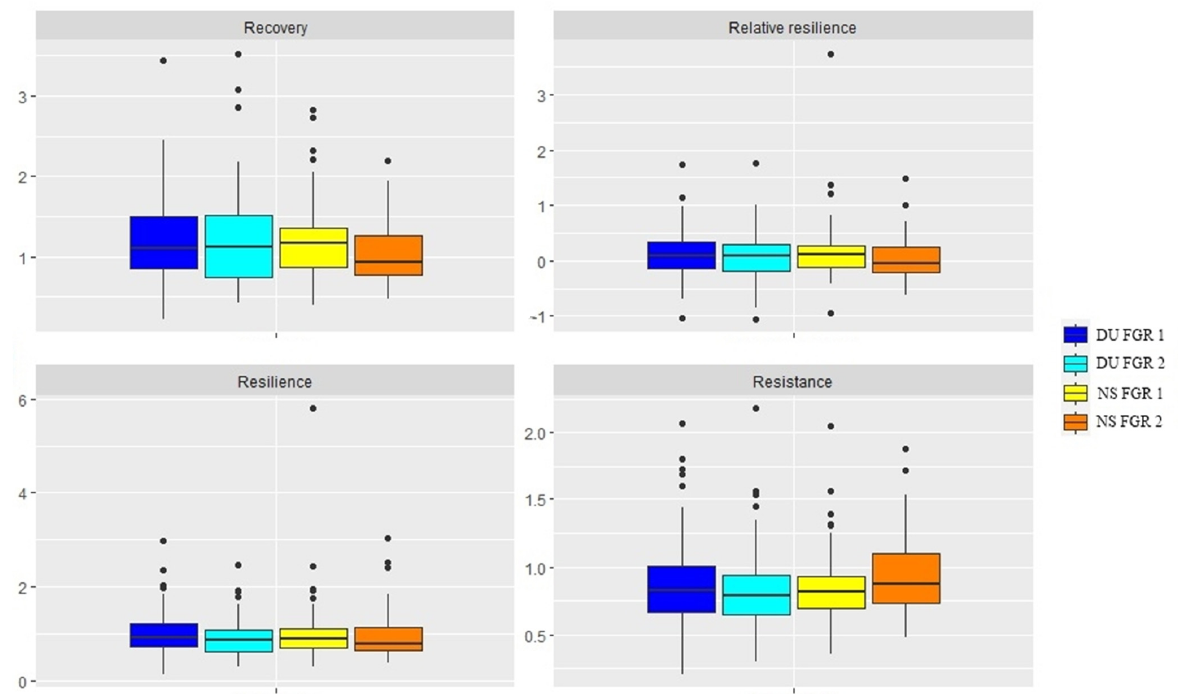
Figure 6. Variation of drought parameters for Douglas fir (DU) and Norway spruce (NS) in forest genetic resources (FGR 1 and FGR 2).